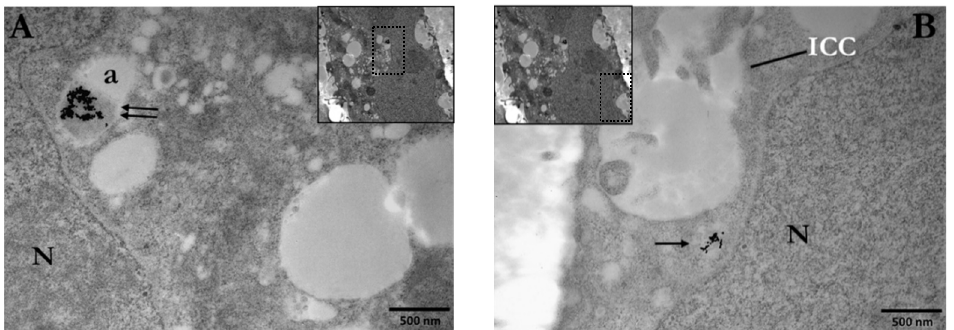
Figure 1. Electron micrographs of PC3 cells indicating the cellular uptake of 15 nm Ct-AuNPs (10 μ g/mL) after 24 h. ( A ) Arrows point to the different areas of the cytoplasm, where nanoparticles are located inside vesicles or autophagosomes. ( B , C ) Higher magnification of ( A ). Ct-AuNPs are located inside vesicles (single arrows) and autophagosomes (double arrows). Red arrows indicate vesicular formations of the plasma membrane by which NPs may be endocytosed or excreted by the cell. Scale bars: ( A ) 2 μ m; ( B ) and ( C ) 1 μ m. N: nucleus, n: nucleolus, m: mitochondrion.